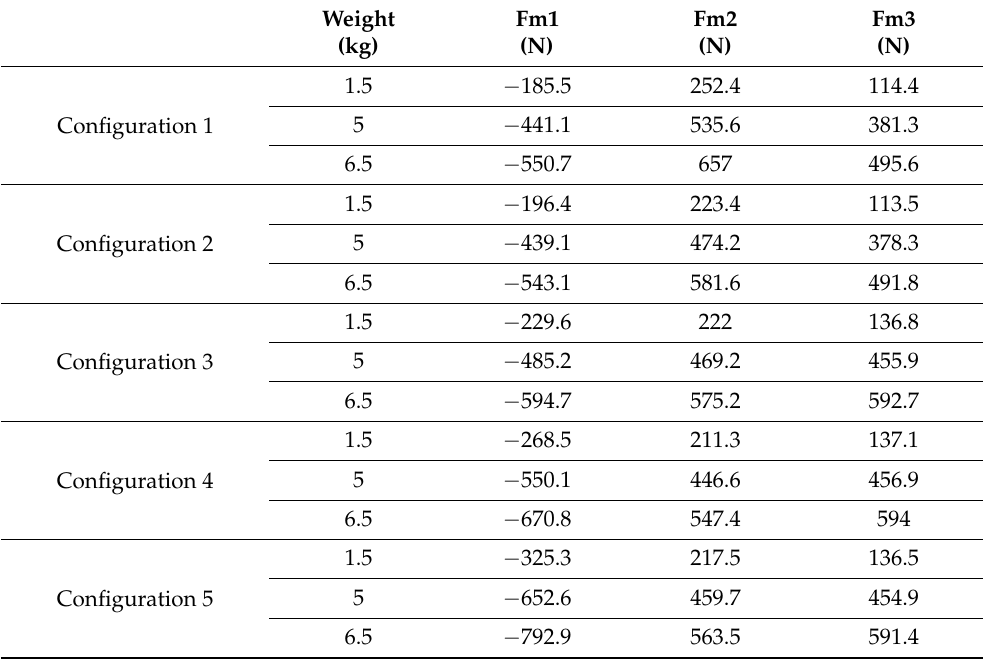
Table 5. Axial forces in linear motors, calculated analytically with Relations (3), (5), and (8).